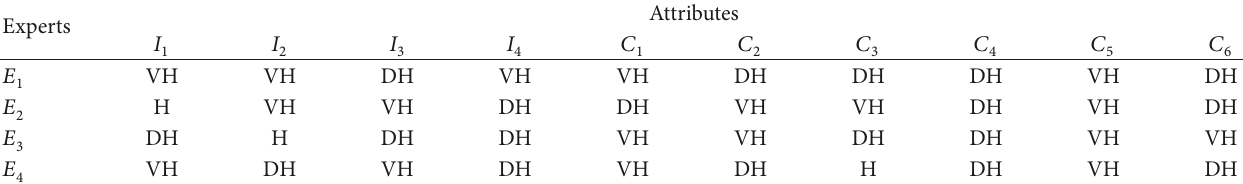
Table 4: Attribute weights evaluated by experts.